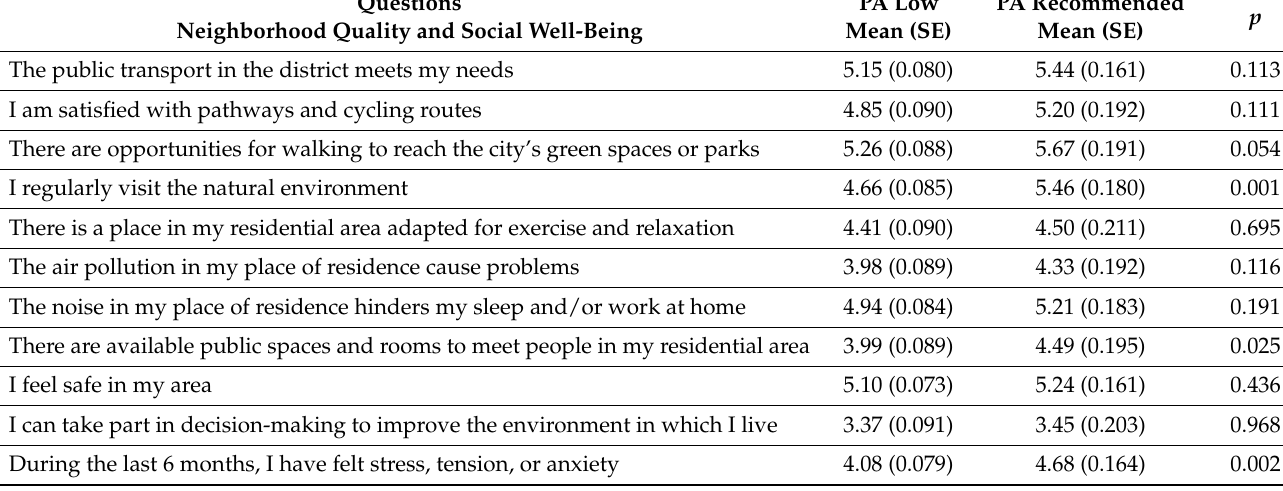
Table 3. Mean ratings of the perceptions of neighborhood quality and social well-being in 45–64-year-old participants by the low and recommended physical activity